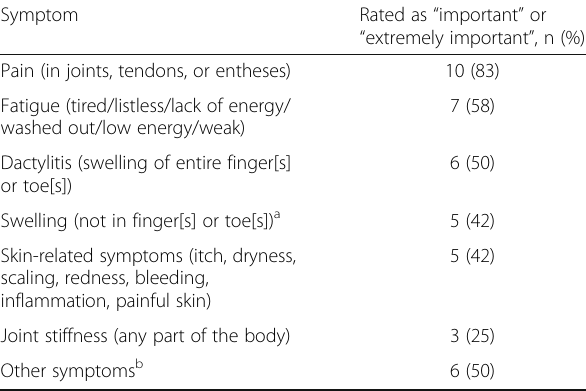
Table 1 Ranking of PsA symptoms by patients in the qualitative study ( N = 12) Symptom Rated as “ important ” or “ extremely important ” , n (%) Pain (in joints, tendons, or entheses) 10